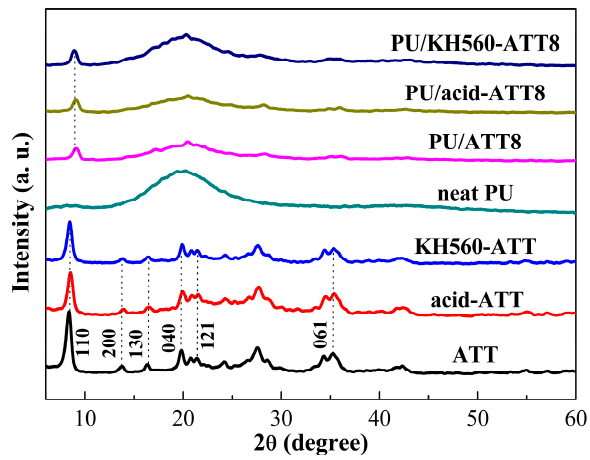
Figure 1. The XRD patterns of different ATTs, neat PU and PU nanocomposites containing 8 wt % ATT, acid-ATT and KH560-ATT. Polymers 2018 , 10 , x FOR PEER REVIEW